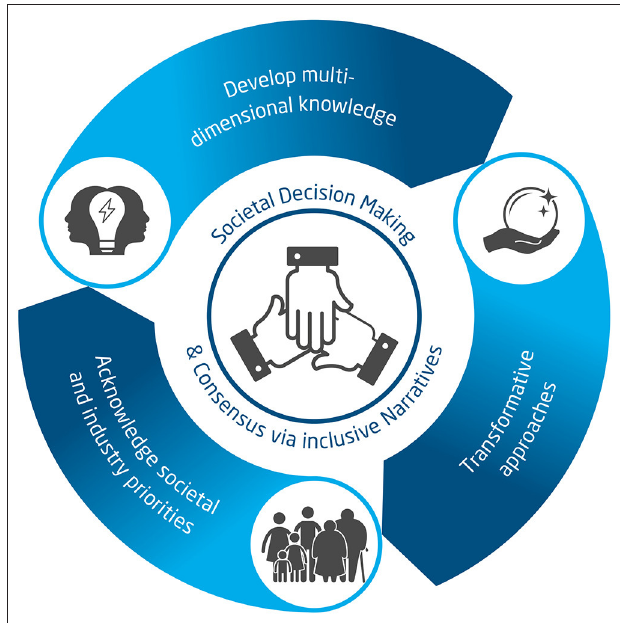
FIGURE 1 | Reflexive co-development toward societal decision-making and consensus via inclusive narratives. ((C) Y.